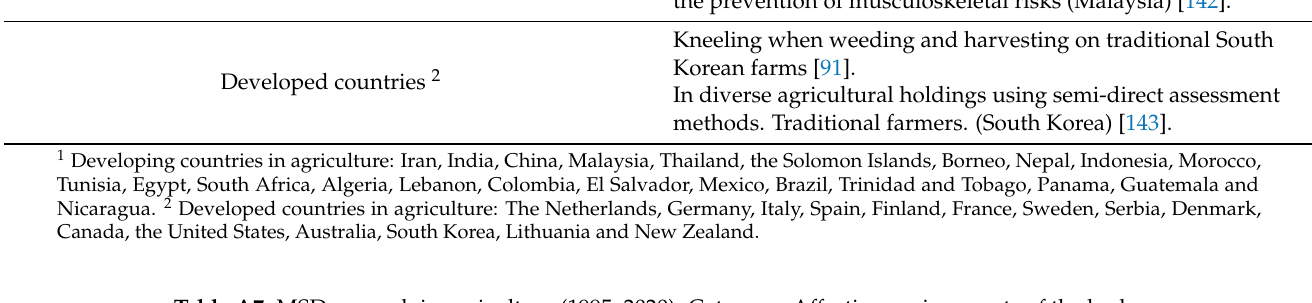
Table A7. MSD research in agriculture (1995–2020). Category: Affecting various parts of the body. Affecting Various Parts of the Body